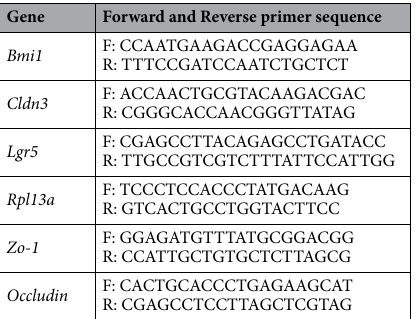
Table 1. Real-time PCR primer sequences. Bmi1 B cell-specific Moloney murine leukemia virus integration site 1, Lgr5 leucine-rich repeat-containing G-protein coupled receptor 5, Rpl13a Ribosomal protein L13A, Zo-1